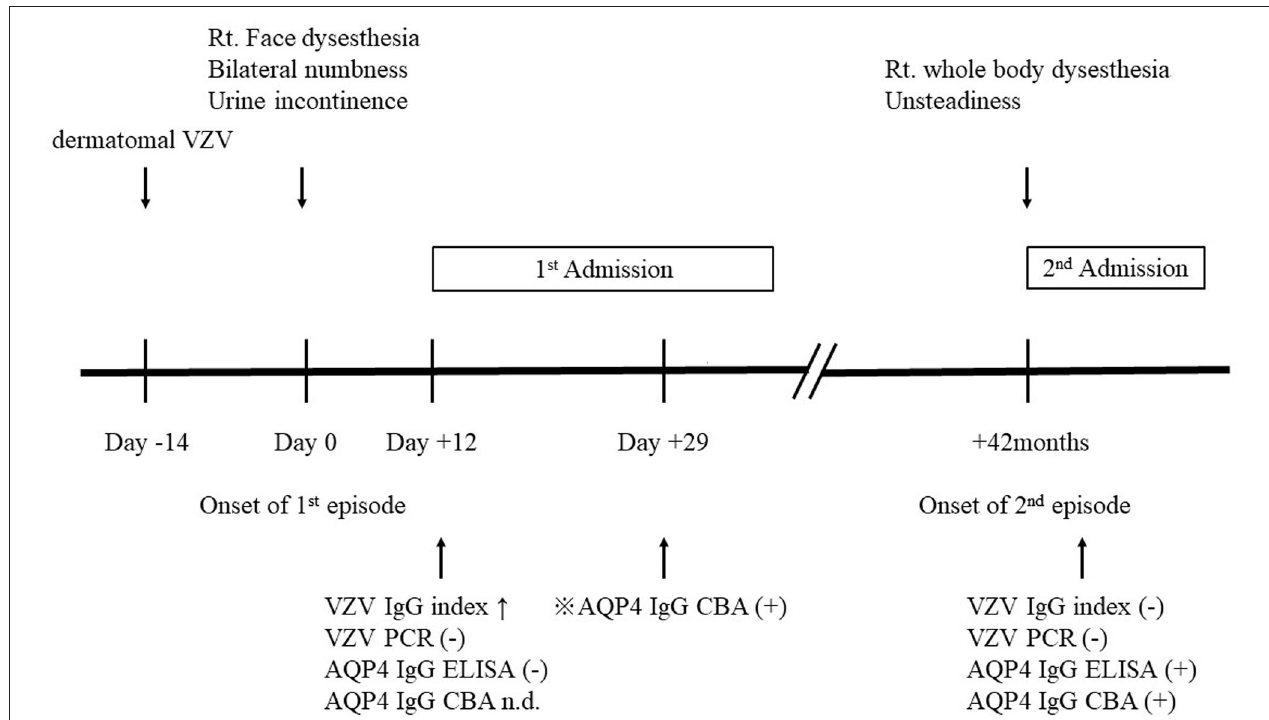
FIGURE 2 | Timeline of patient’s disease. Rt, right; VZV, varicella-zoster virus; n.d., not determined; AQP4-IgG, aquaporin-4 immunoglobulin-G; ※ detected